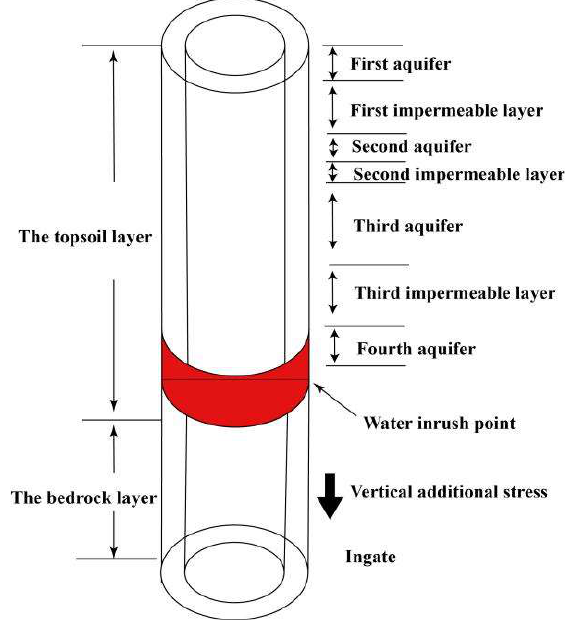
Figure 1. The schematic diagram of wellbore damage.